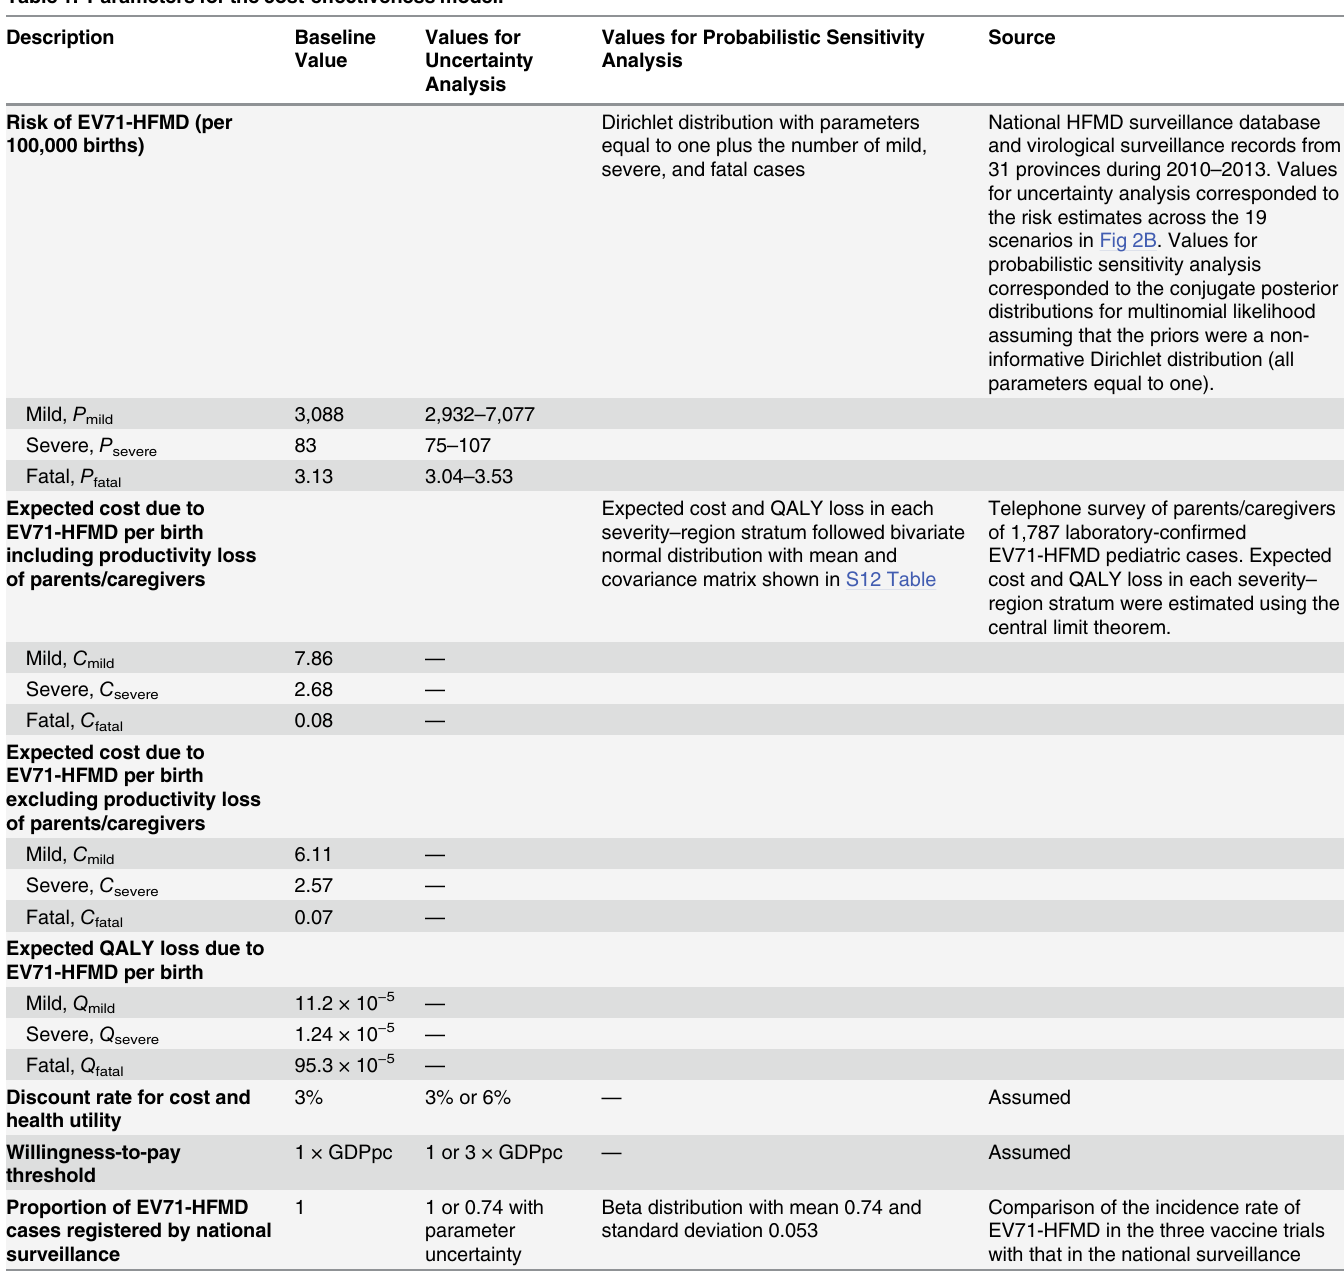
Table 1. Parameters for the cost-effectiveness